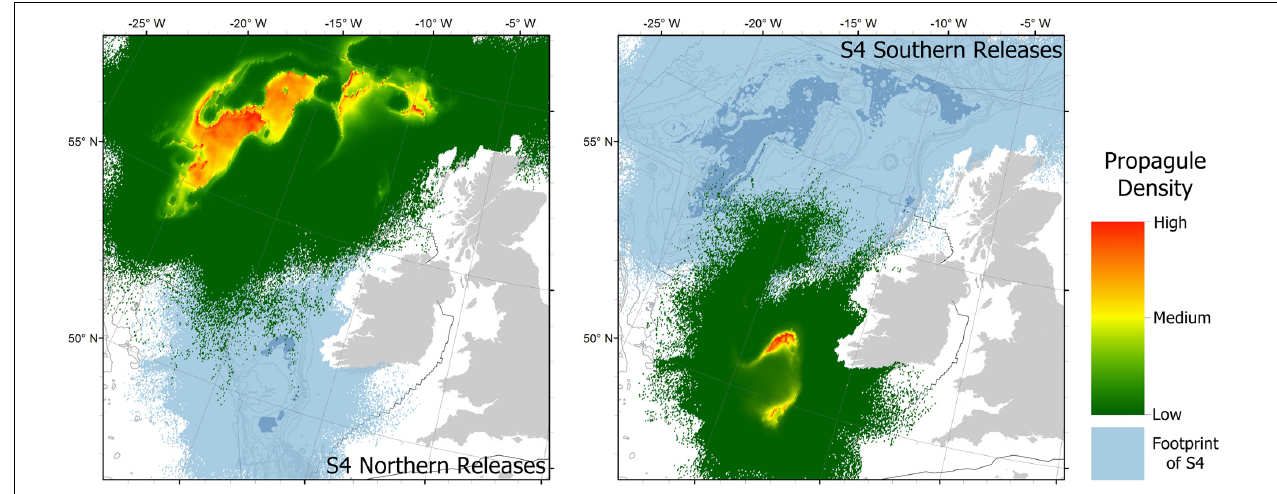
FIGURE 3 | The scenario 4, 50 day Planktonic Larval Duration (PLD) simulations re-visualized showing the full footprint of scenario 4 broken down into those released from the north, and those released from the south. Colors now show densities of larvae rather than PLDs. Background bathymetry contours from GEBCO show every 200–1000 m depth, then every 500 m. Black lines show the current extent of the United Kingdom and Irish continental shelves within the study area.